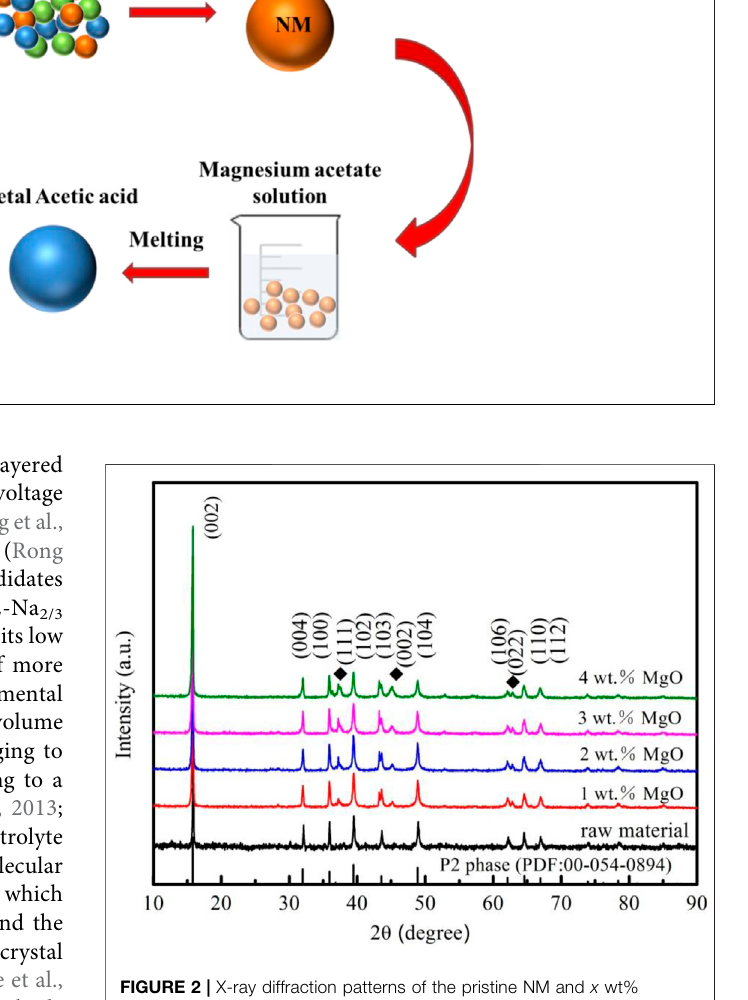
FIGURE 2 | X-ray diffraction patterns of the pristine NM and x wt% MgO-modi fi ed NM ( x = 1, 2, 3, and 4)